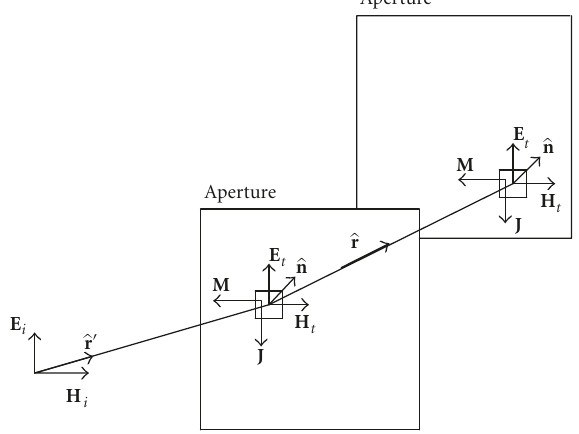
Figure 9: Basic outline of the physical optics calculation.